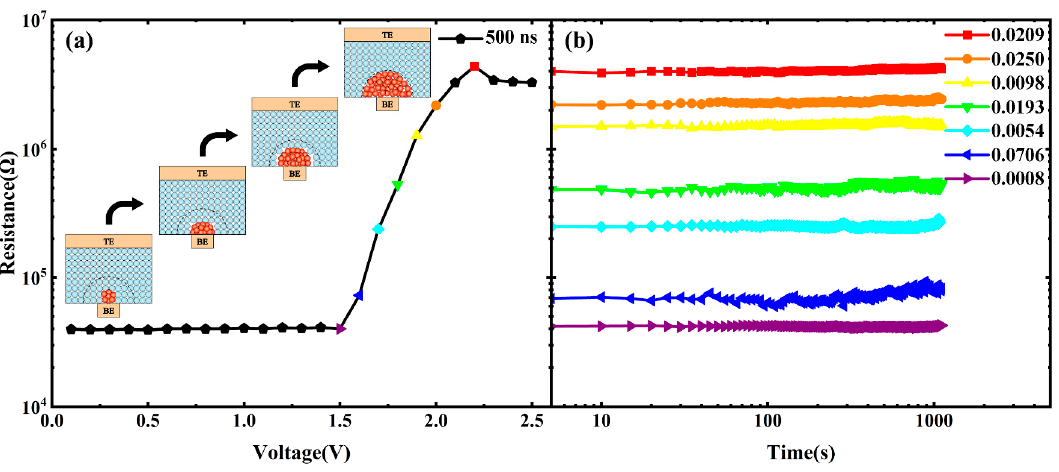
Figure 10. ( a ) The R-V curve is obtained by resetting the voltage pulse with a pulse width of 500 ns, and ( b ) the R-t curve and the resistance drift coefficient ν is obtained by fitting with Equation ( 2).